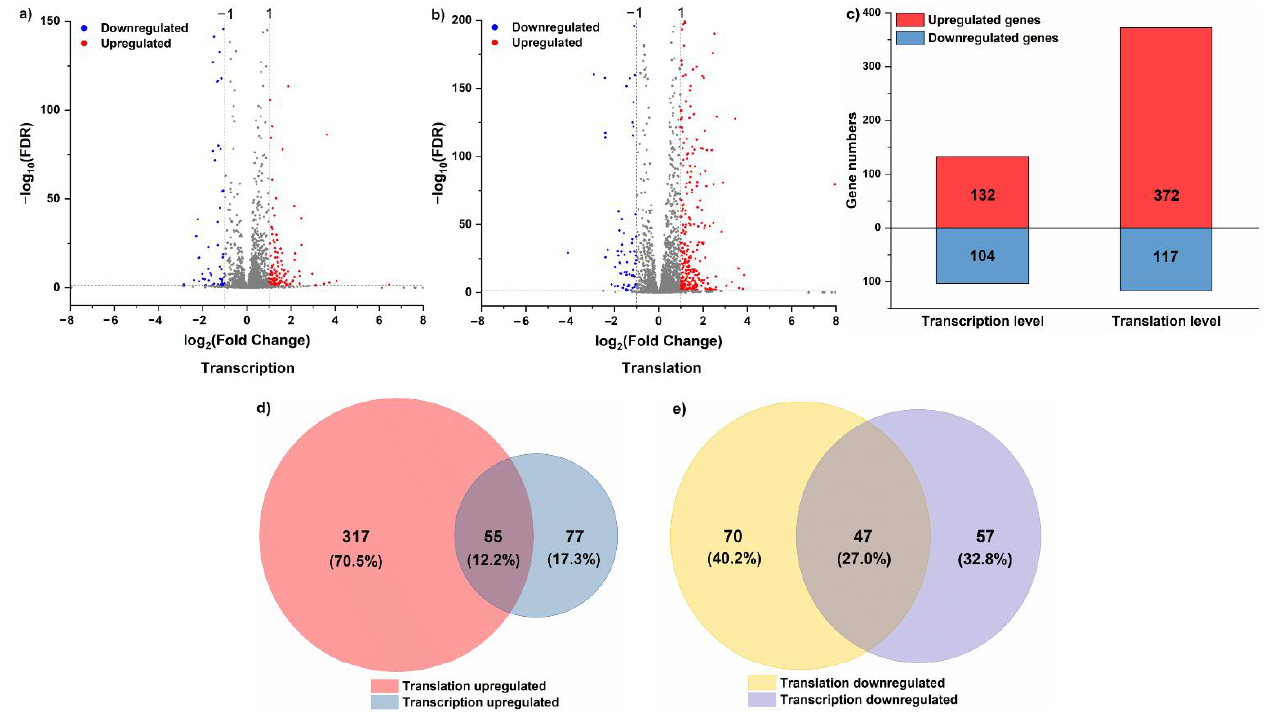
Figure 1. ( a ) The volcano map of DEGs in L. rhamnosus ATCC 53103 at the transcriptional level under acid stress ( | log 2 fold change | > 1 and FDR < 0.05). ( b ) The volcano map of DEGs in L. rhamnosus ATCC 53103 at the translational level under acid stress ( | log 2 fold change | > 1 and FDR < 0.05). ( c ) The number of DEGs in L. rhamnosus ATCC 53103 under acid stress at the transcriptional or translational levels. ( d ) The relationships between upregulated DEGs at these two levels. ( e ) The relationships between downregulated DEGs at these two levels.